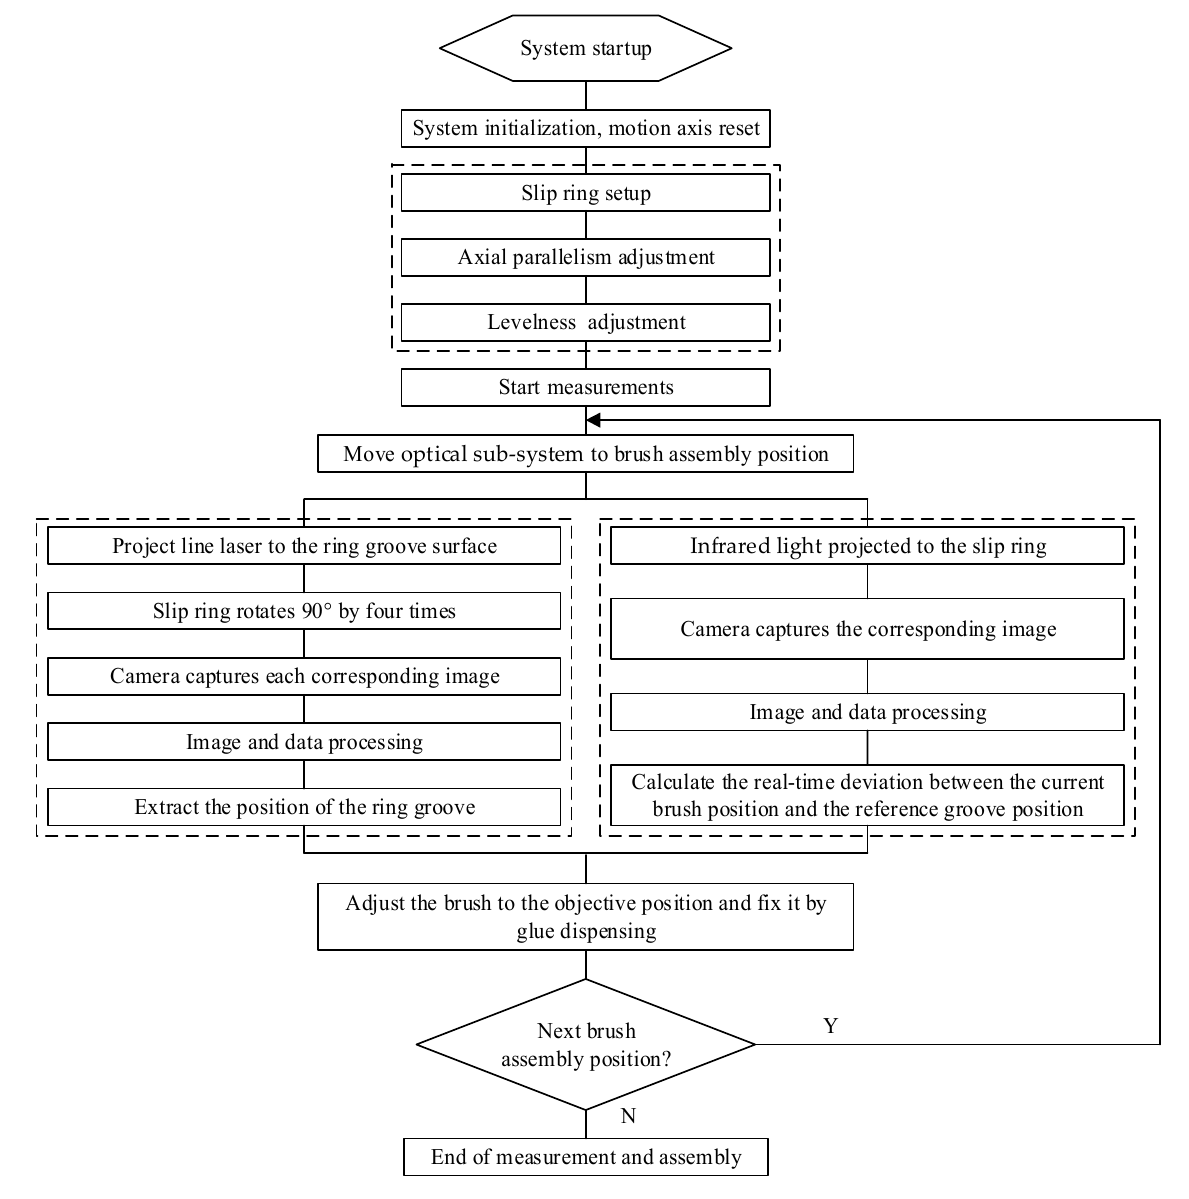
Figure 3. Vision-aided brush alignment assembly procedures. During one measurement, the optical sub-system mounted on the direct drive linear motor stage is moved to the theorical position of the specific conductive ring. In order to measure the groove positions, the line laser is projected onto the ring groove surface, and the slip ring is rotated by 90 ◦ four times and the camera captures each corresponding image, respectively. The image and data processing are then carried out to extract the mean value of the ring groove position as the target position of the brush alignment